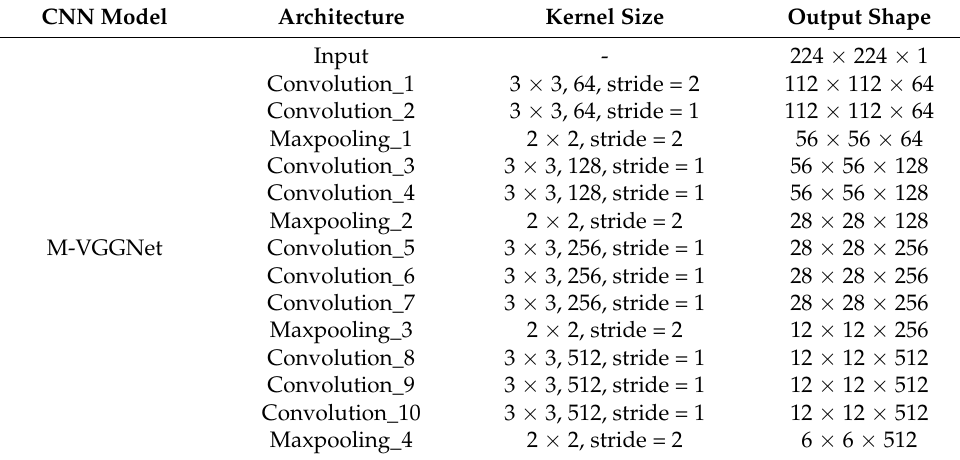
Table 4. The architecture of